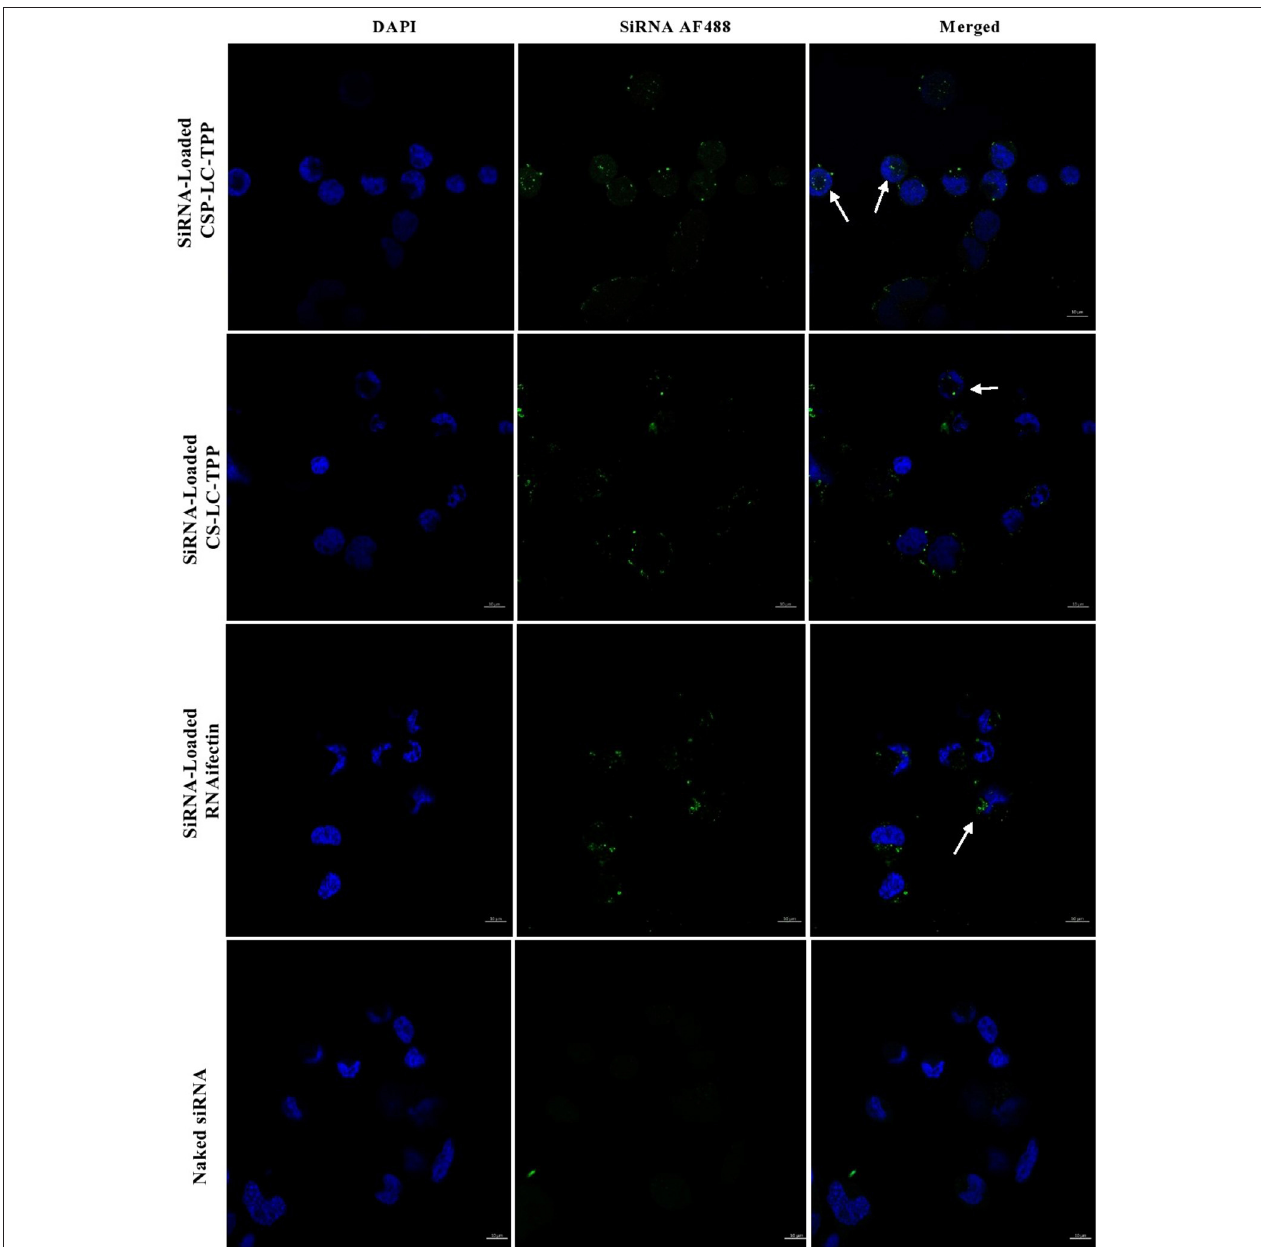
FIGURE 6 | Confocal fluorescence microscopy images showing MDA-MB-453 cancer cells treated with fluorescent siRNA AF488-loaded CS-LC-TPP NPs and CSP-LC-TPP NPs. RNAifectin loaded with fluorescent siRNA AF488 and naked siRNA AF488 were studied as controls. All treatments are equivalent to 50nM siRNA over 4-h periods. White arrows point nanoparticles up taken into cellular cytoplasm. Scale = 10 µ m.